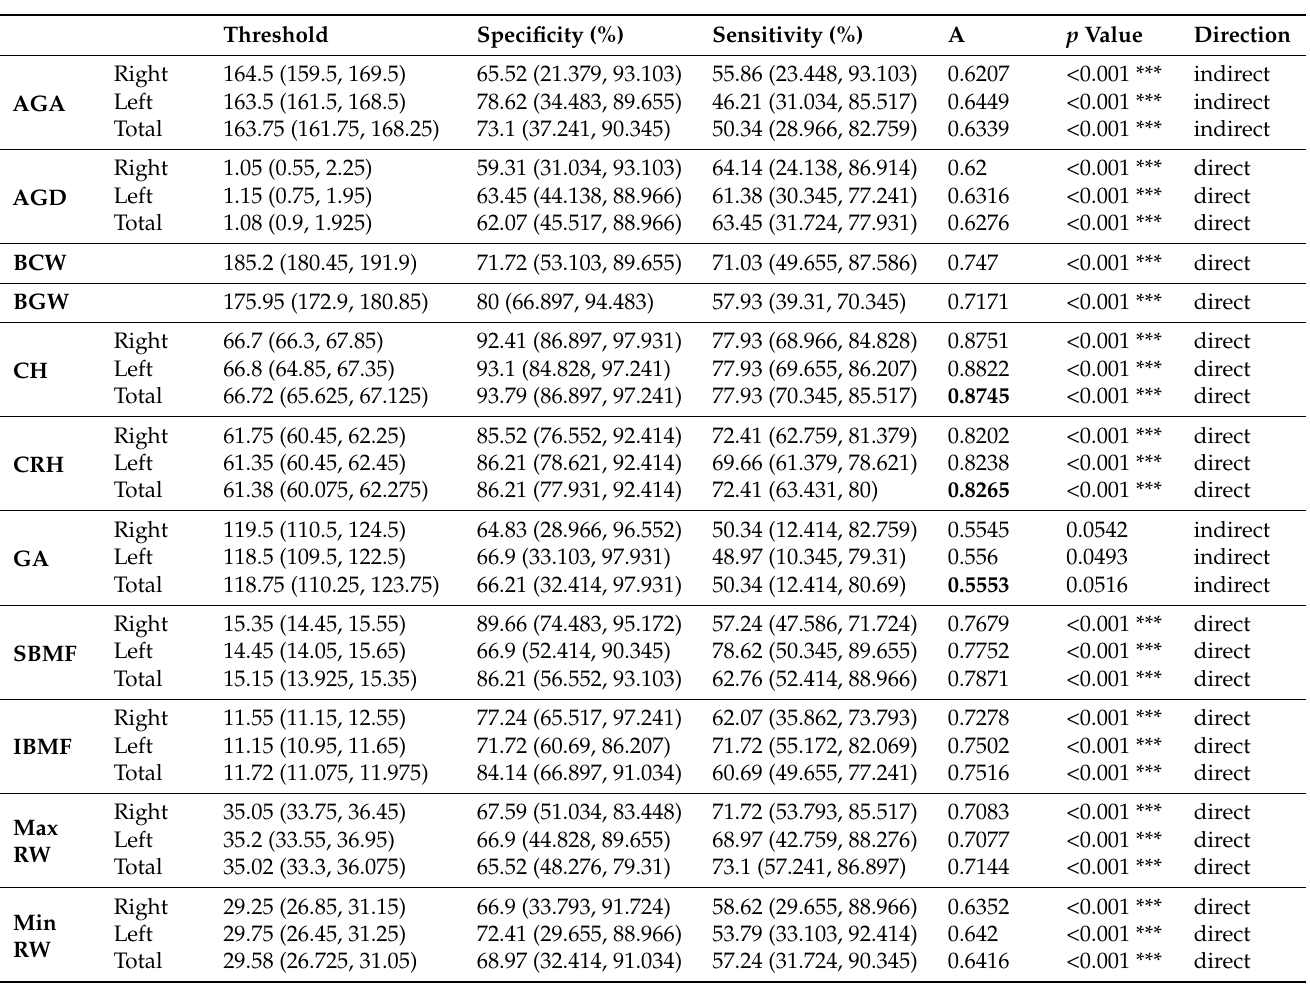
Table 2. Sensitivity and specificity of indices in the right and left sides and the mean of both sides for gender